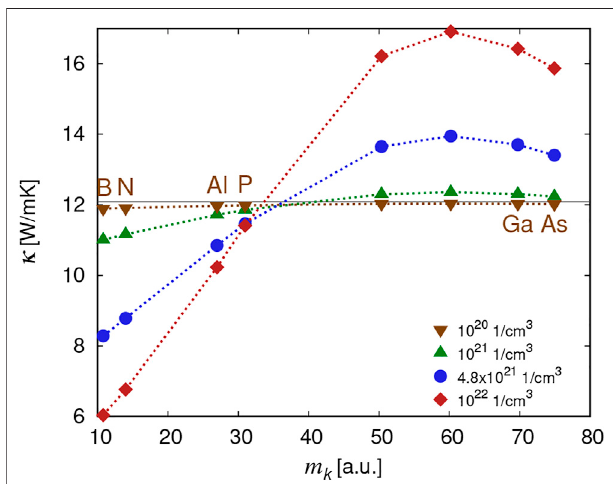
FIGURE4| ThermalconductivityinSi 0.5 Ge 0.5 asafunctionoftheatomic mass m k of the dopant for various doping concentrations. The horizontal gray line indicates the thermal conductivity in undoped Si 0.5 Ge 0.5 .